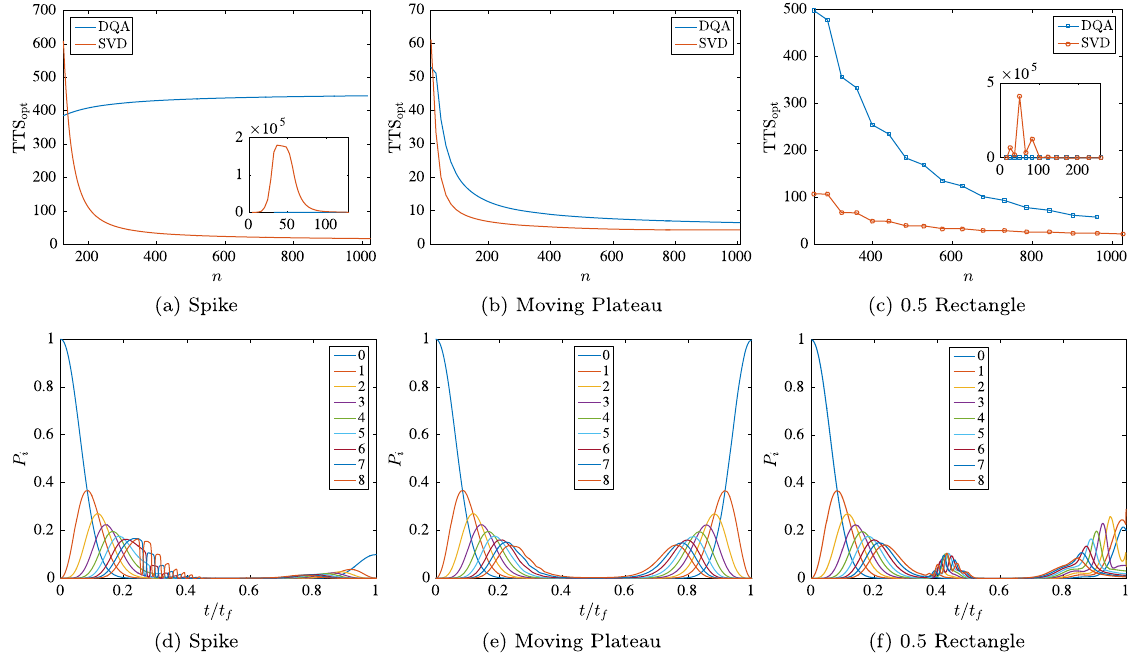
FIG. 8. (a) – (c) The optimal TTS for the spike, moving plateau, and 0.5-rectangle problems, respectively. Inset for (a) and (c): The optimal TTS for small problem sizes, where we observe SVD at first scaling poorly. However, as n grows, this difficulty vanishes and it quickly outperforms DQA. (d) – (f) Population P in the i th energy eigenstate along the diabatic QA evolution at the optimal TTS. We i 9 . 85 for the spike, n ¼ 512 and observe similar diabatic transitions for these problems (shown are the cases with n ¼ 512 and t f ¼ 10 for the moving plateau, and n ¼ 529 and t 9 . 8 for the 0.5-rectangle problems) as we observed for the fixed plateau problem t f ¼ f ¼ [Fig.